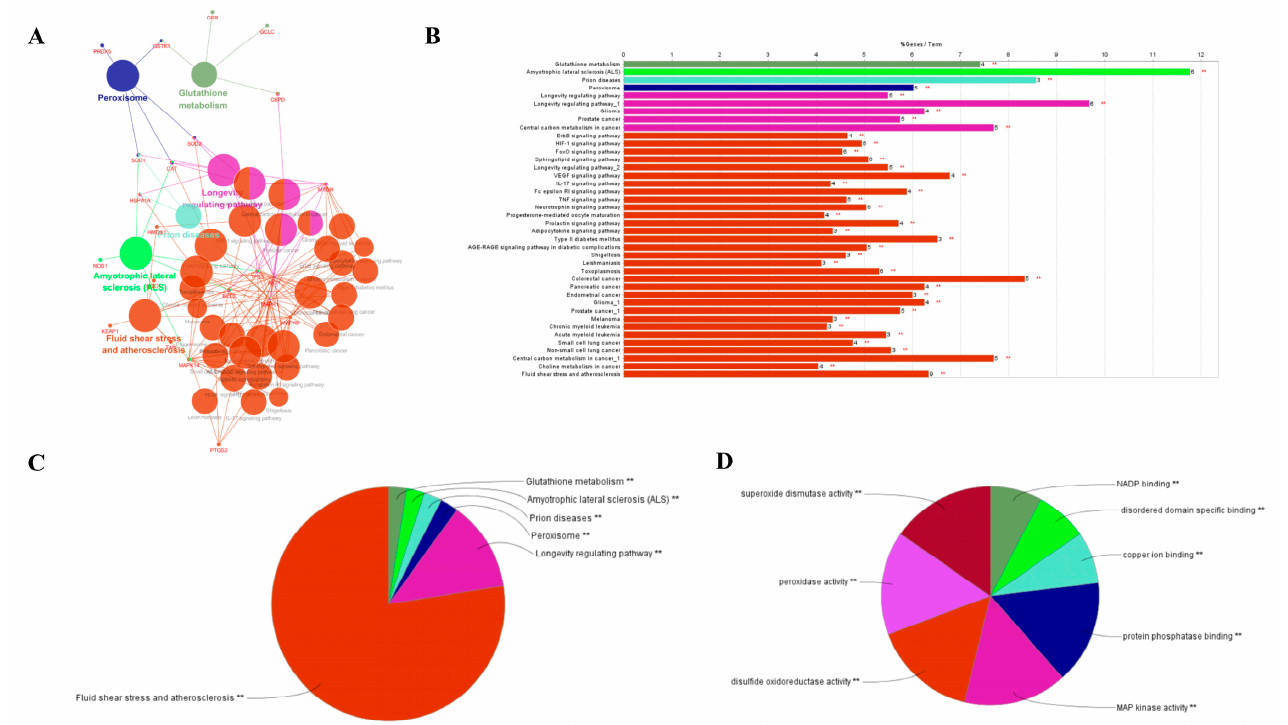
Figure 5. Molecular function and metabolic pathway analysis of EGb. ( A ) “Targets-Pathway-Disease” network of EGb; ( B ) Gene percent involved with these pathways and diseases; ( C ) Six primary pathways related with antioxidation; ( D ) Eight antioxidant mechanisms of EGb. ** Indicates that the p -value is less than 0.01.